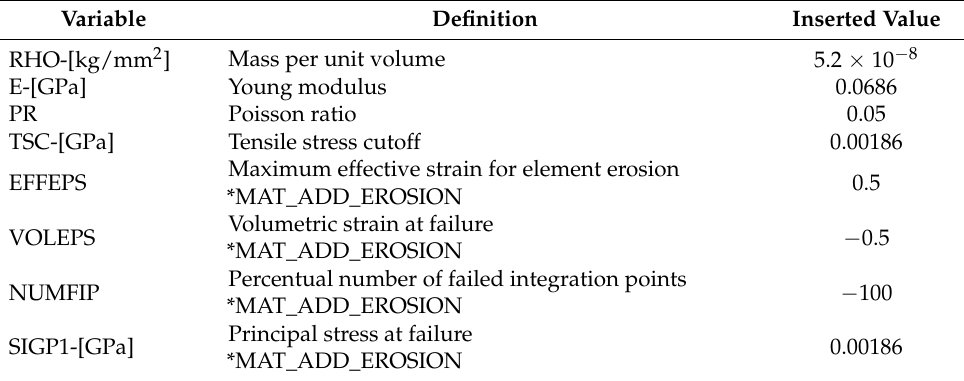
Table 7. MAT63 material properties for crushable closed-cell